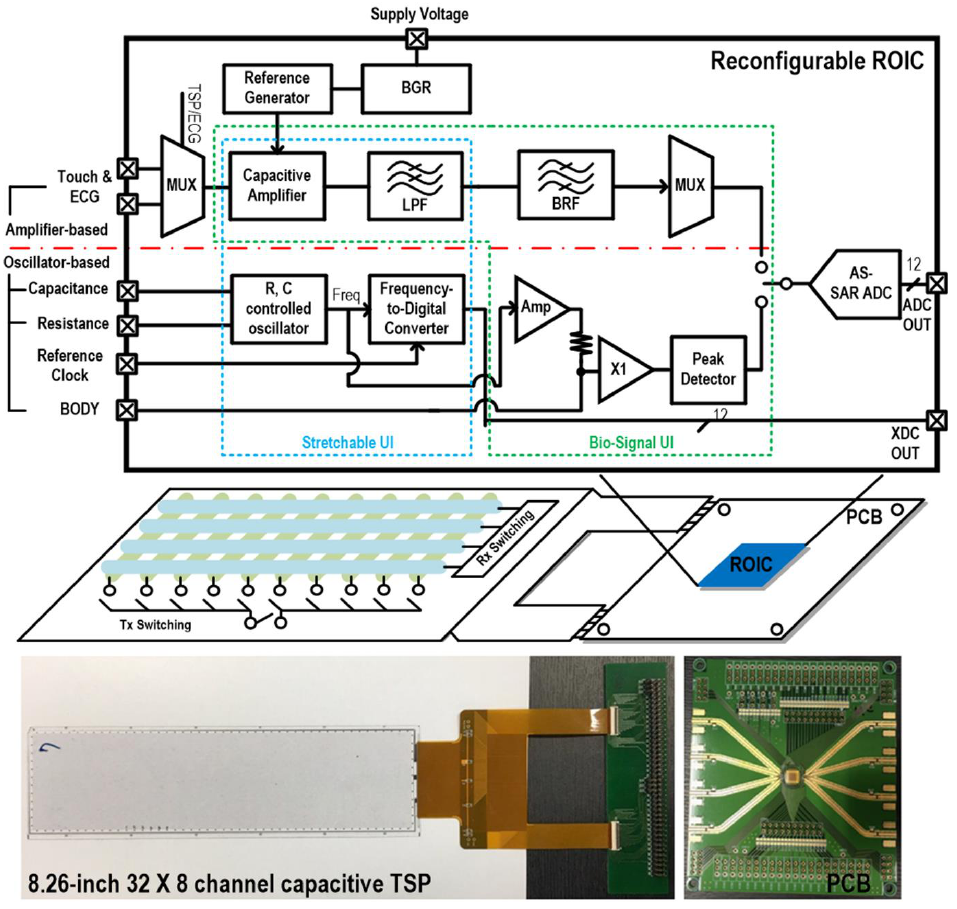
Figure 1. Display-based multi-sensor interface and reconfigurable readout integrated circuit.